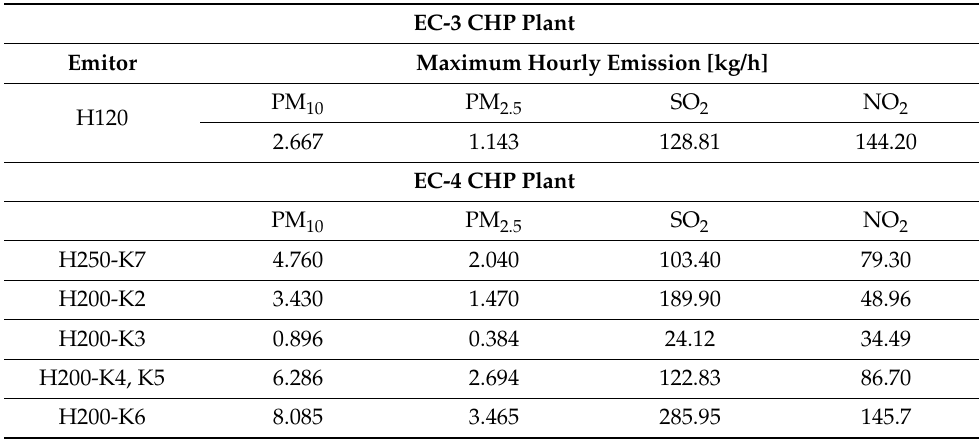
Table 3. Maximum hourly emissions of pollutants for EC-3 and EC-4 CHP plants in 2019 (own calculations based on data from Veolia Energia Ł ó